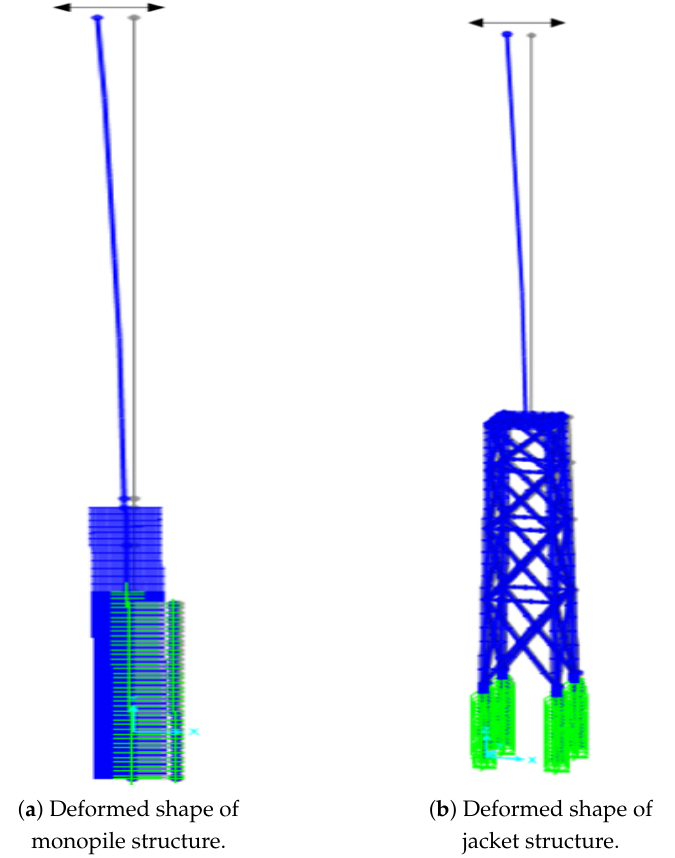
Figure 15. Typical deformed shapes of monopile and jacket structures during